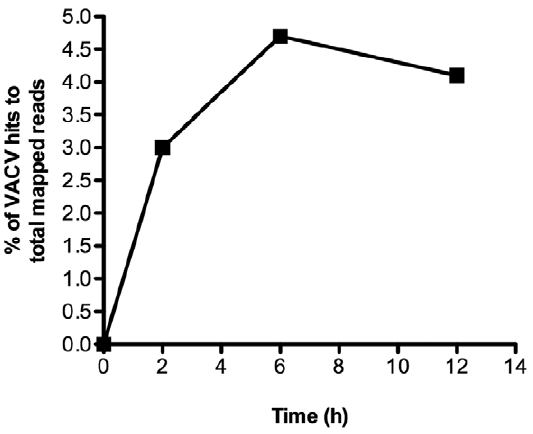
Figure 6. Relative amount of VACV mRNA in infected S2 cells. Total polyadenylated RNA was extracted at various times after infection and subjected to deep RNA sequencing. The sequences were divided into those that mapped to the Drosophila and VACV genomes. The percentage of the sequence hits to VACV genome relative to the total mapped reads at progressive time after infection is shown.